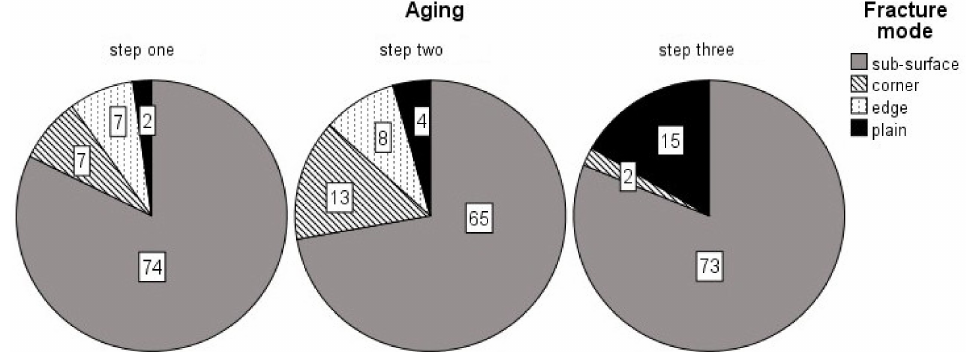
Figure 3. Circle chart of the observed fracture modes after each aging